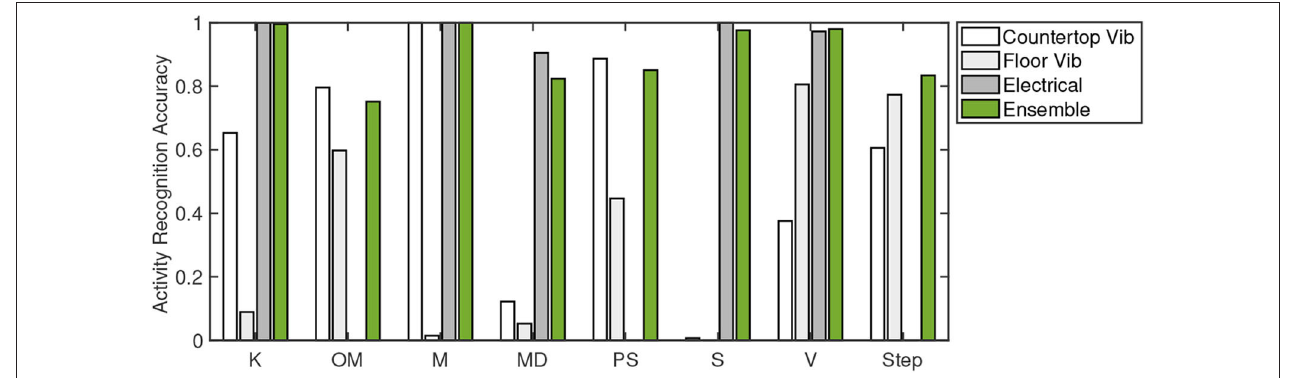
FIGURE 10 | Sliding window level ADL recognition accuracy—compared to single sensor performance.